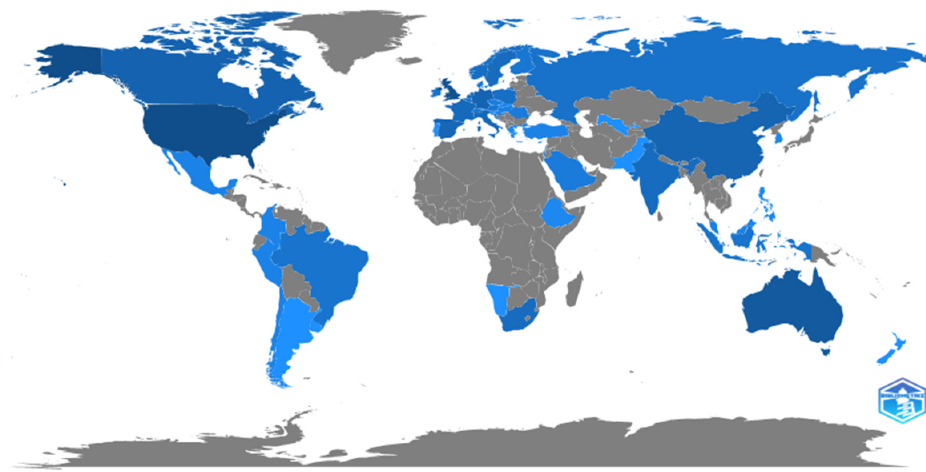
Figure 5. Scientific Production by country. It is generated by “Biblioshiny” in RStudio.